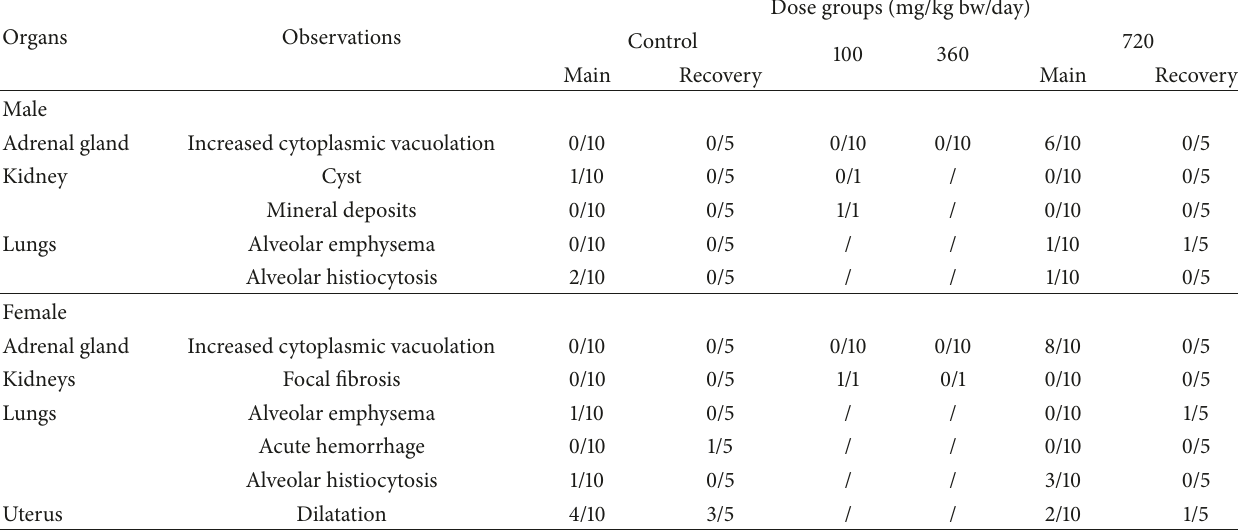
Table 15: Summary of notable histopathology findings in the 90-day repeated oral toxicity